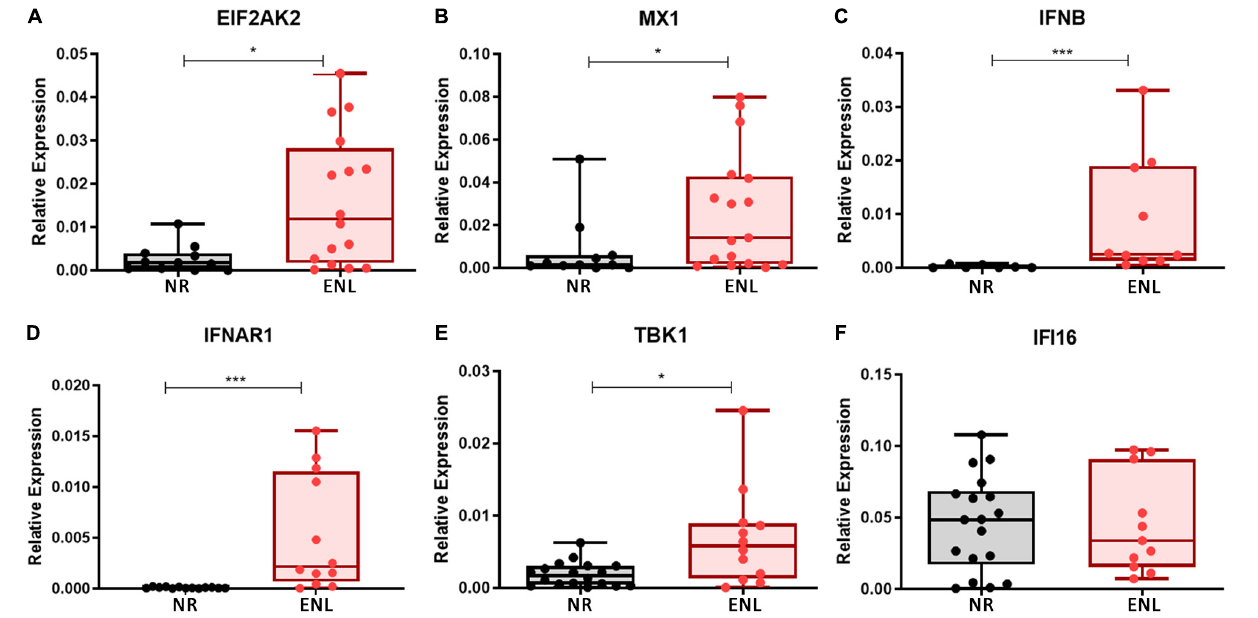
FIGURE 2 | Type I IFN signature genes are upregulated in ENL skin lesions. Skin lesions of non-reactional multibacillary patients (NR, black ) or ENL patients (ENL, red ) were processed in TRIzol R (cid:13) reagent for RNA extraction and gene expression was determined by RT-qPCR for the following ISGs: (A) EIF2AK2 (NR = 12, ENL = 16); (B) MX1 (NR = 11, ENL = 17); (C) IFNB (NR = 7, ENL = 10); (D) IFNAR1 (NR = 13, ENL = 12); (E) TBK1 (NR = 18, ENL = 12); and (F) IFI16 (NR = 18, ENL = 11). RPL13 was used as an endogenous control. Box plots show median, interquartile range, sample minimum and maximum. Each dot represents a donor. * p < 0.05; *** p <